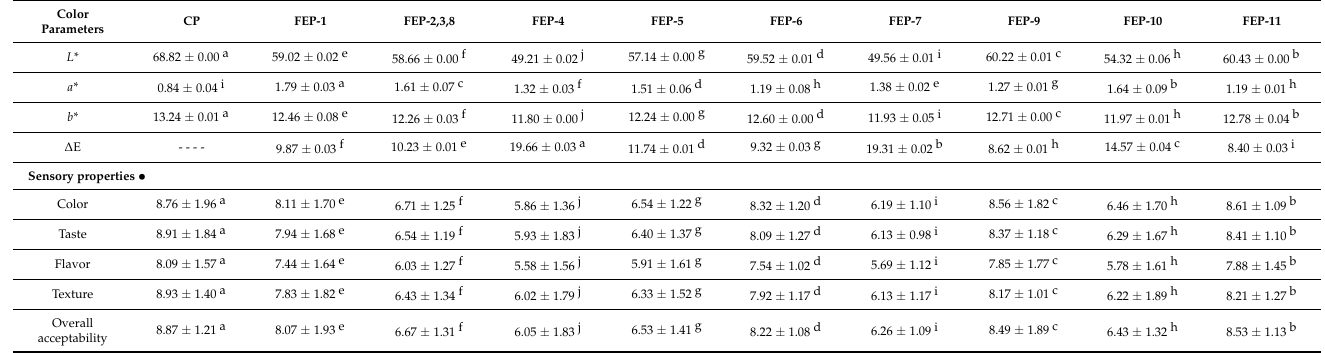
Table 5. Color parameters and sensorial traits of fiber-enriched pasta (FEP).